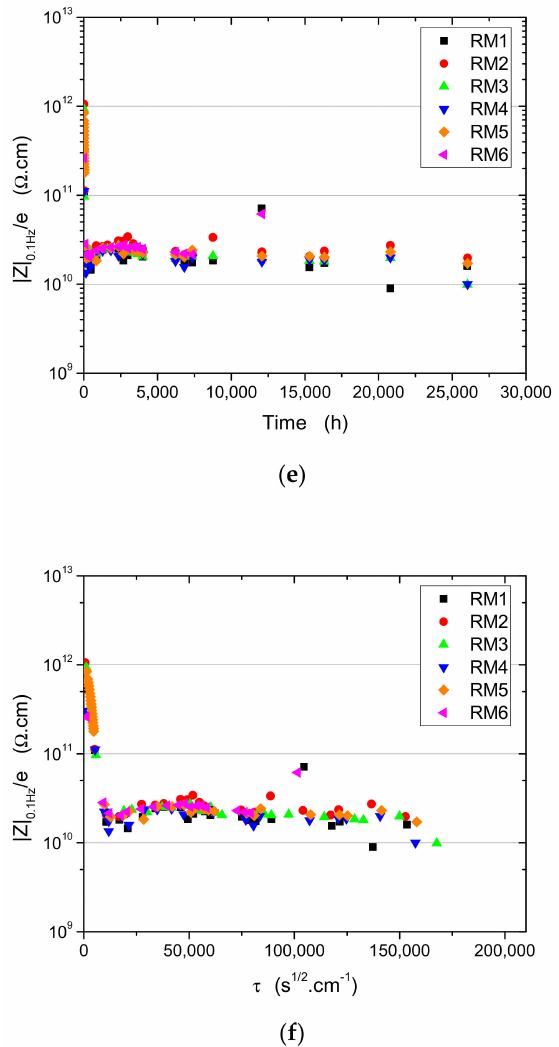
Figure 4. Evolution of the reduced impedance modulus |Z| 0.1 Hz /e vs. ageing time for ROX system ( a ), RG system ( c ), and RM system ( e ) and evolution of the reduced impedance modulus |Z| 0.1 Hz /e vs. reduced time for ROX system ( b ), RG system ( d ), and RM system ( f ) during the immersion at 35 ◦ C in